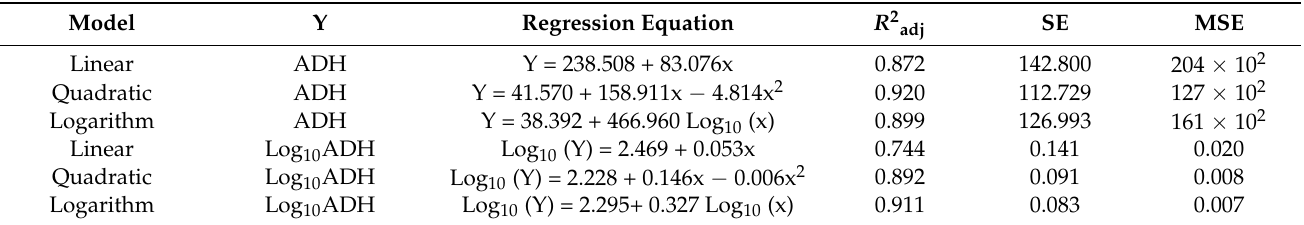
Figure 5. Scatter plot ( n = 2566) of Lucilia sericata developed based on ADH values and body lengths at each developmental stage. It shows a constant relationship during feeding larval stages ( ≤ 1551.60 ADH), minimum ADH values for each developmental stage, and the possibility of tran- sition forms as a forensic indicator. Table 2. Linear and nonlinear regression models during immature stages using ADH and Log 10 ADH values ( n = 973). Model